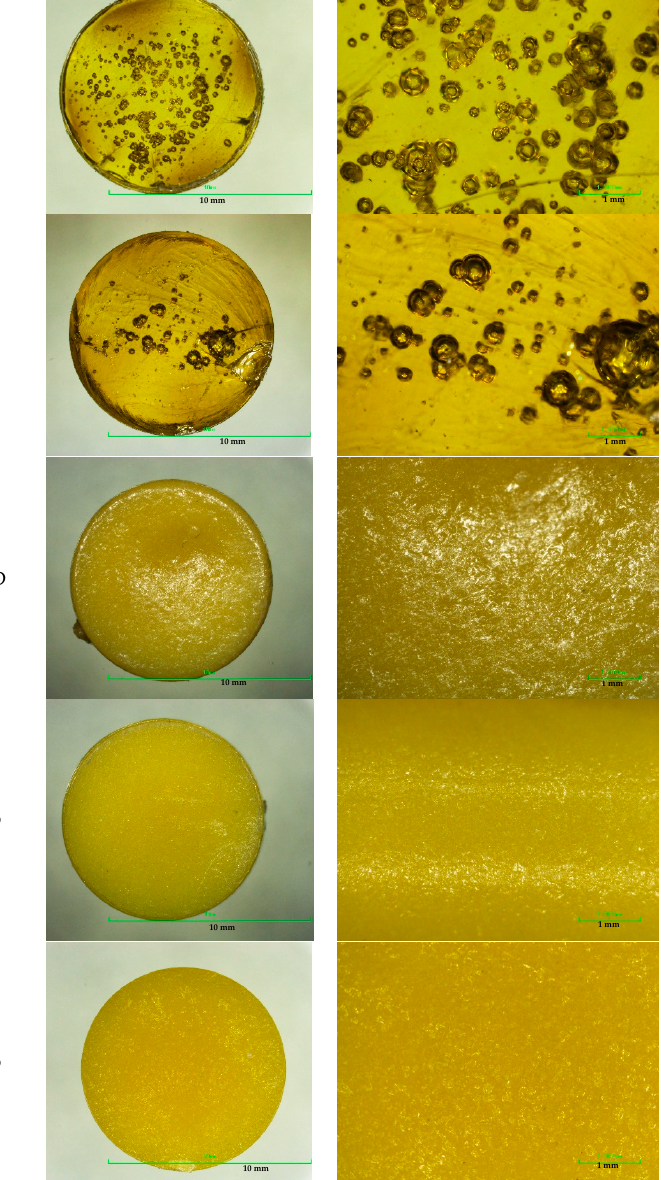
Figure 2. Physical aspect of moulded solid dispersions tablets.